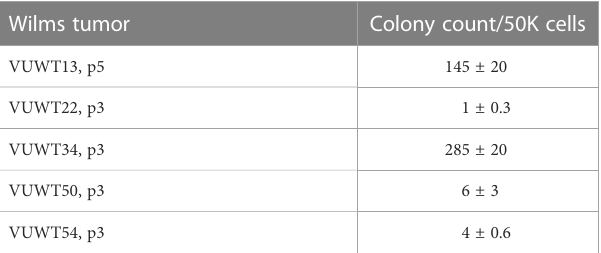
TABLE 3 Colony formation in agarose by cultured Wilms tumor cells. Wilms